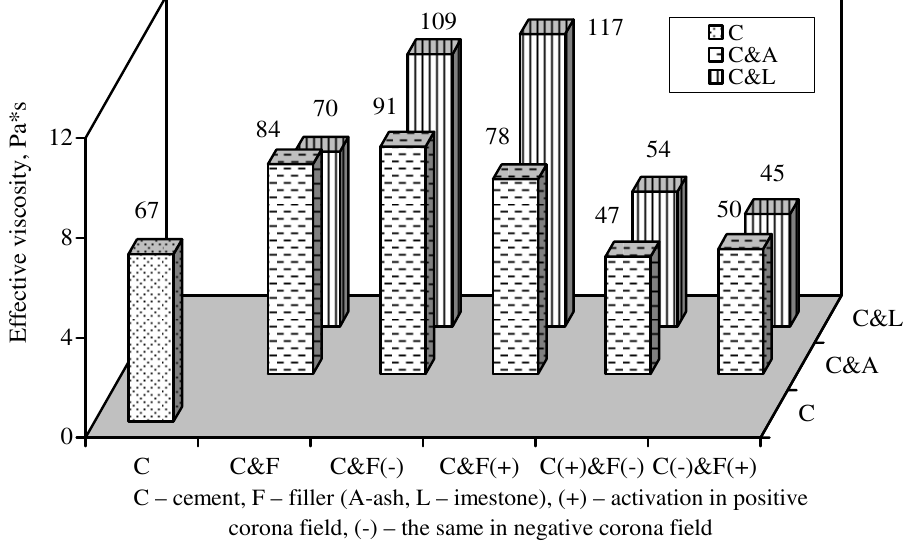
Fig 6. Effective viscosity of concrete